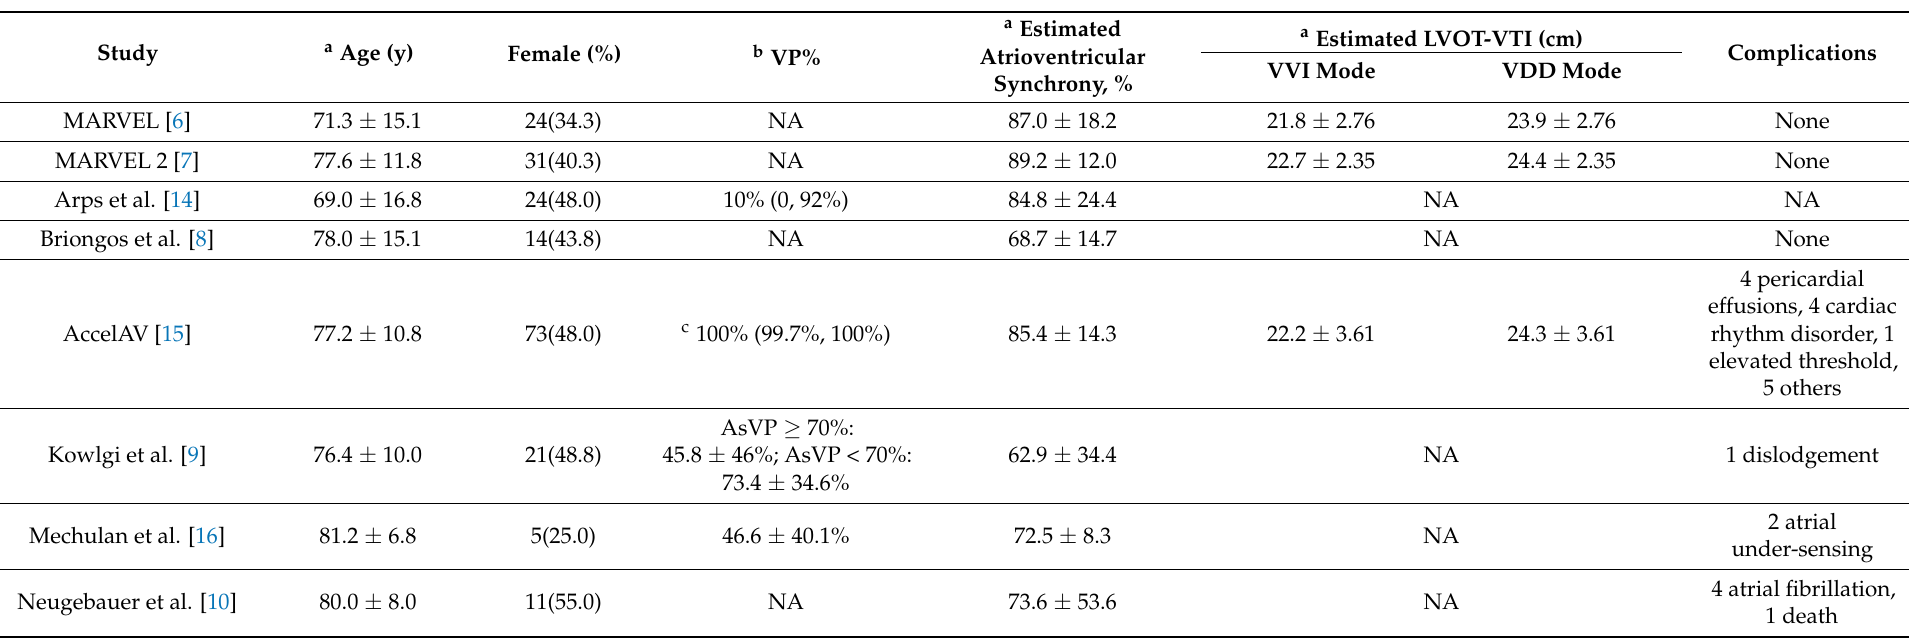
Table 2. Baseline characteristics of the participants in the included